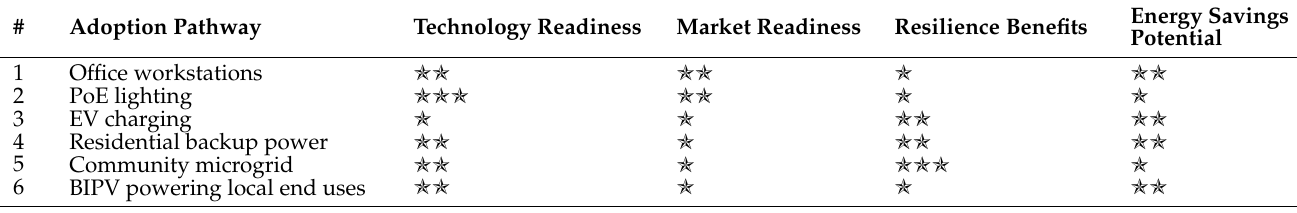
Table 6. Evaluation of the proposed adoption